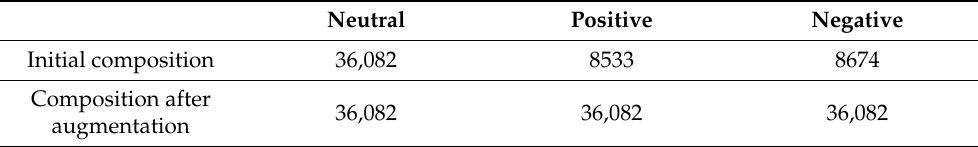
Table 3. Dataset composition before and after